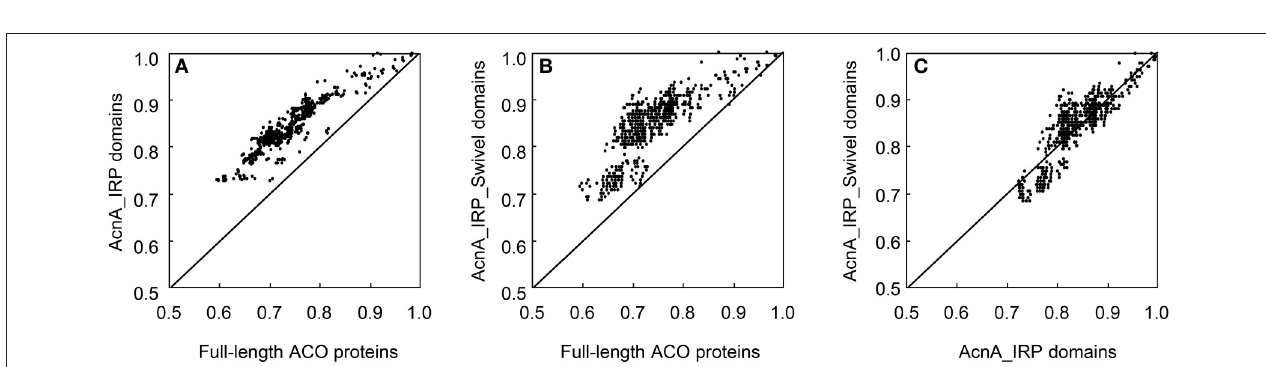
FIGURE 2 | Pairwise protein sequence identity plots for the full-length ACO proteins vs. AcnA_IRP domain (A) ,full-length ACO proteins vs. AcnA_IRP_Swivel domain (B) , and AcnA_IRP domain vs. AcnA_IRP_Swivel domain (C) .